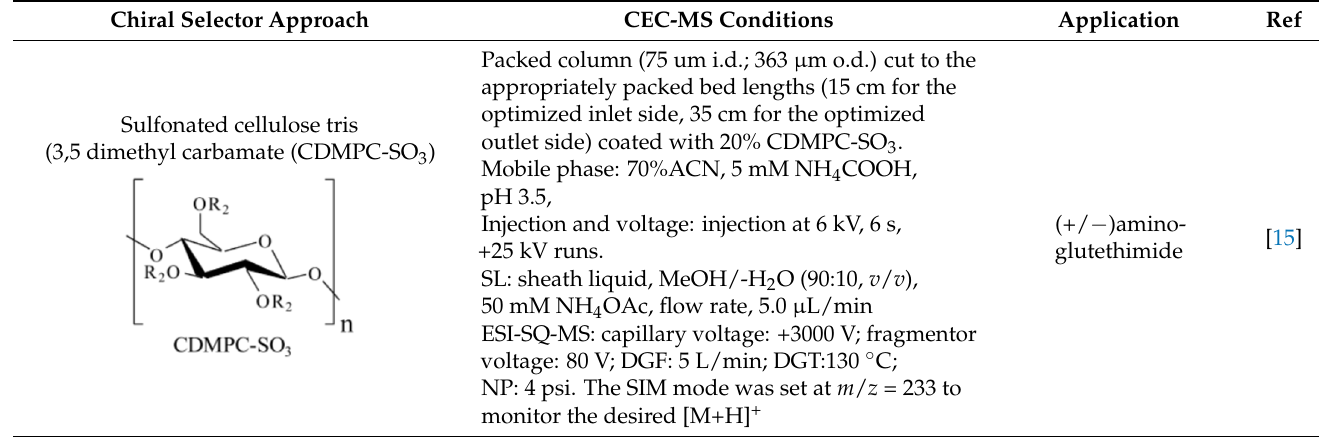
Table 3. Different types of chiral selectors and their applications in CEC-MS and LE-CEC-MS.